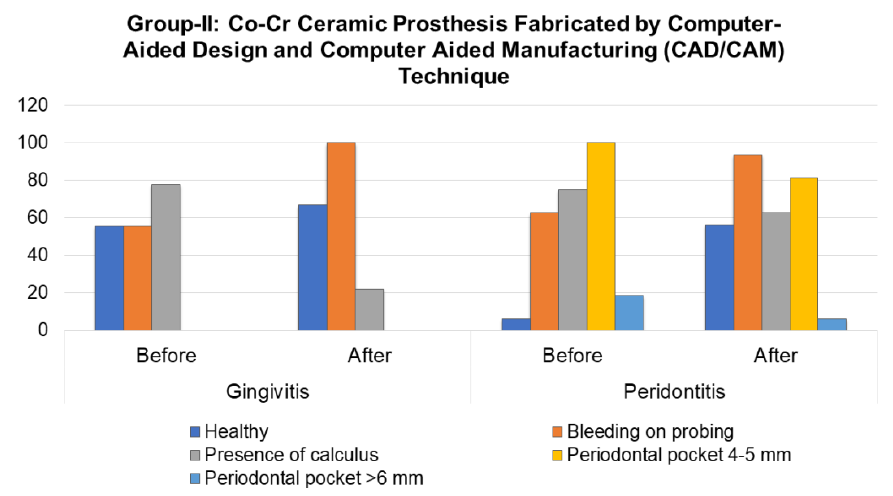
Figure 2. Periodontal status evaluation before and after the prosthetic rehabilitation in observation Group-II patients.